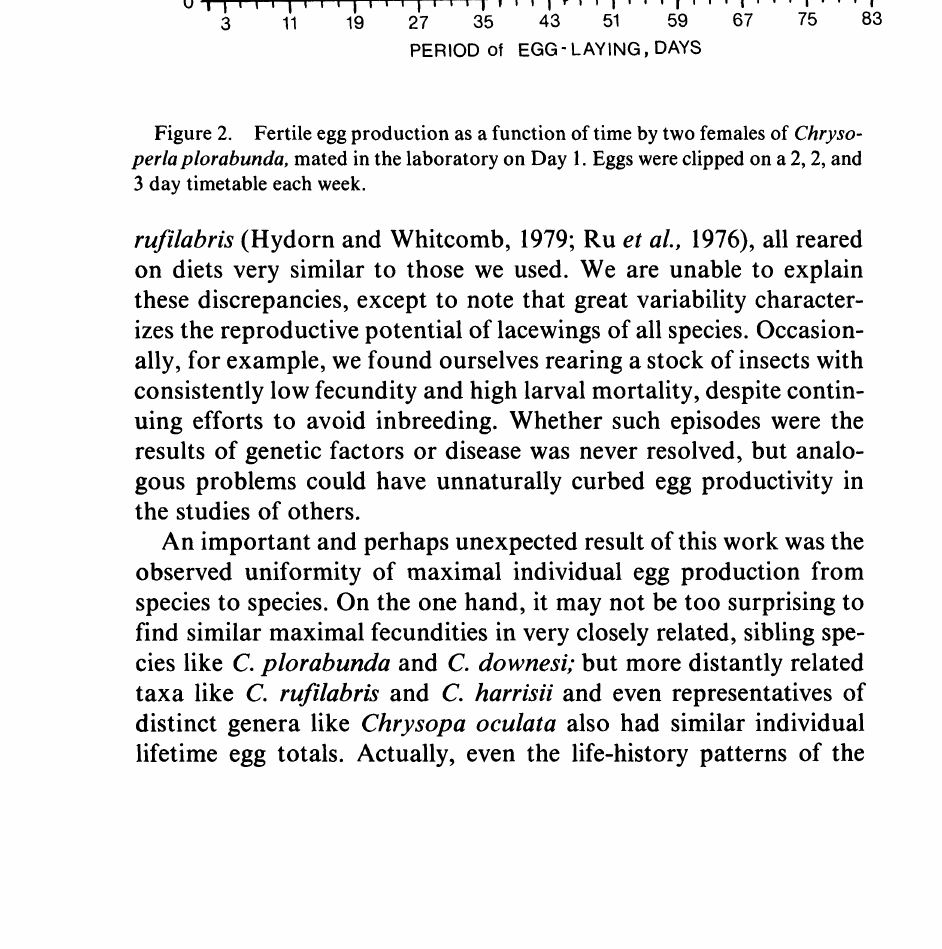
Figure 2. Fertile egg production as a function of time by two females of Chryso- perla plorabunda, mated in the laboratory on Day 1. Eggs were clipped on a 2, 2, and 3 day timetable each week. rufilabris (Hydorn and Whitcomb, 1979; Ru et al., 1976), all